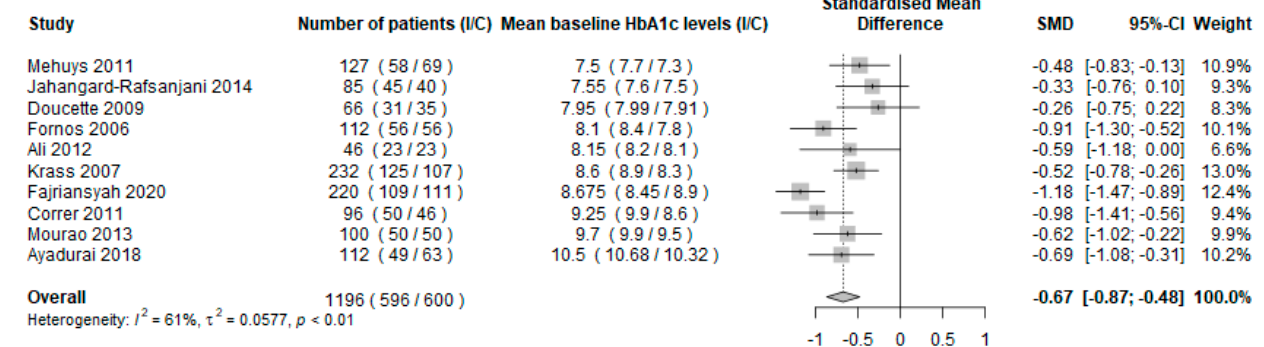
Figure 2. Forest plot of the mean difference in HbA1c levels in the intervention group compared with the usual pharmaceutical care group using random effects model. Abbreviations: I = interven- tion group; C = control group; HbA1c = glycated